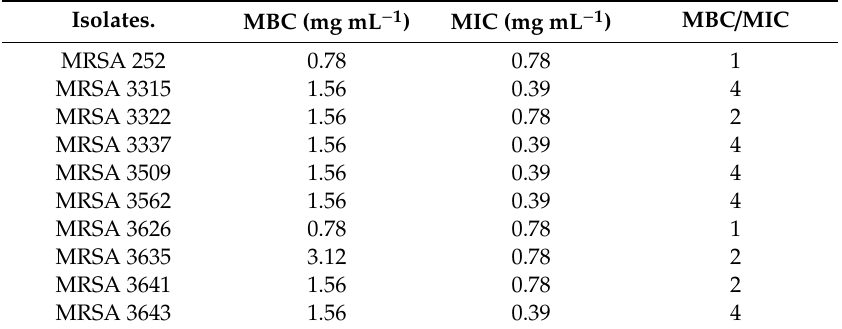
Table 1. The ratio of minimal bactericidal concentration / minimal inhibitory concentration (MBC / MIC) of Pongamia pinnata extract against 10 methicillin-resistant Staphylococcus aureus (MRSA) isolates. Isolates.